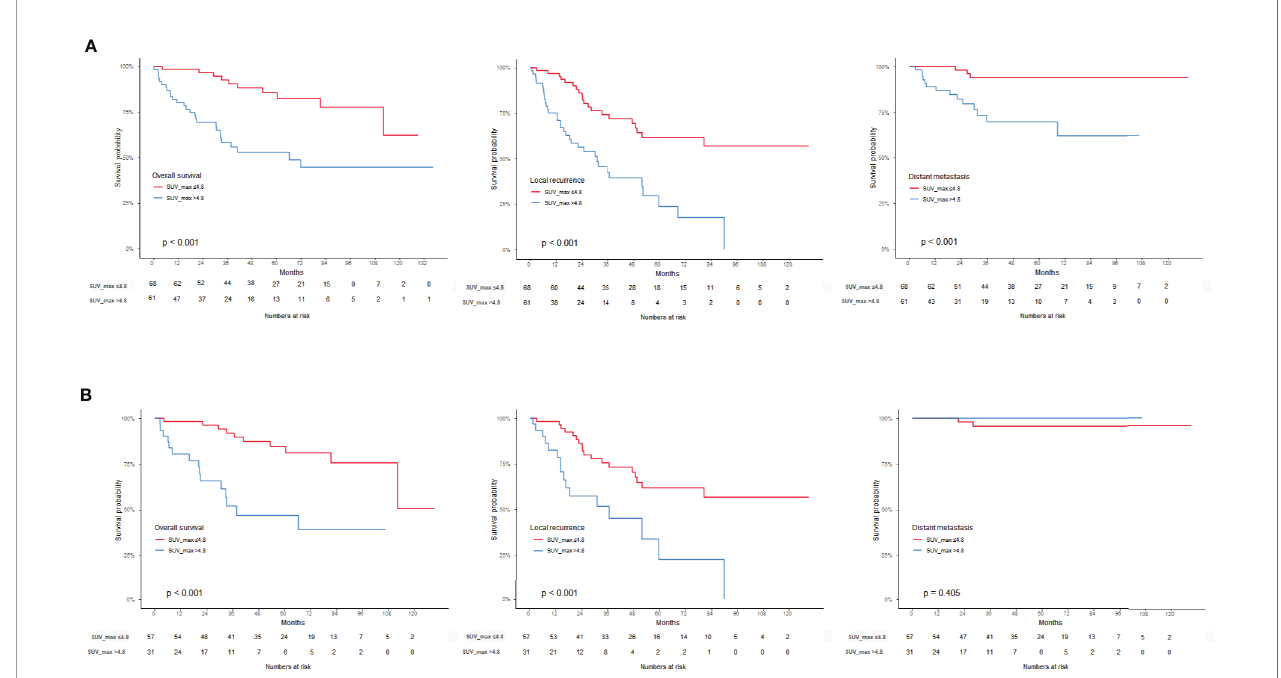
FIGURE 3 | Kaplan-Meier survival graph compared to the SUVmax threshold of 4.8. (A) OS, LR, DM in RPS group, (B) OS, LR, DM in LPS